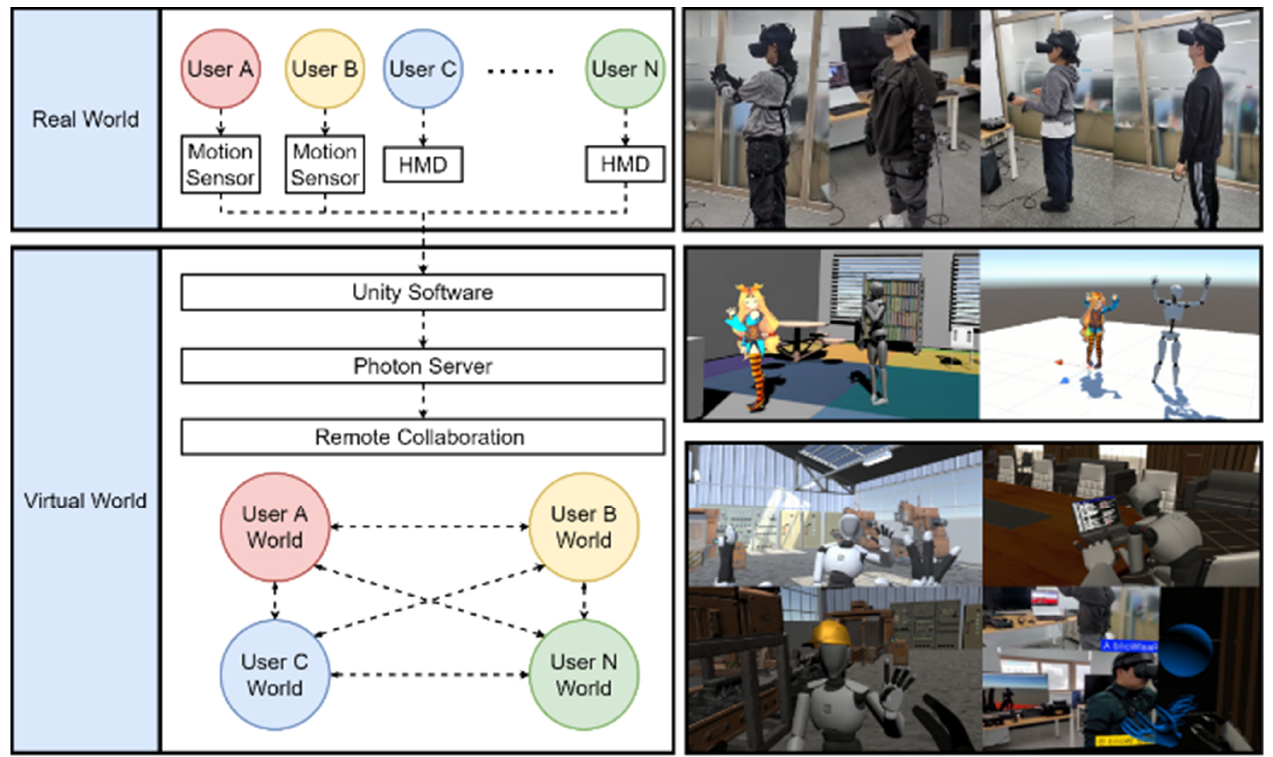
Figure 3. Motion capture-based multi-remote realistic collaboration system process.